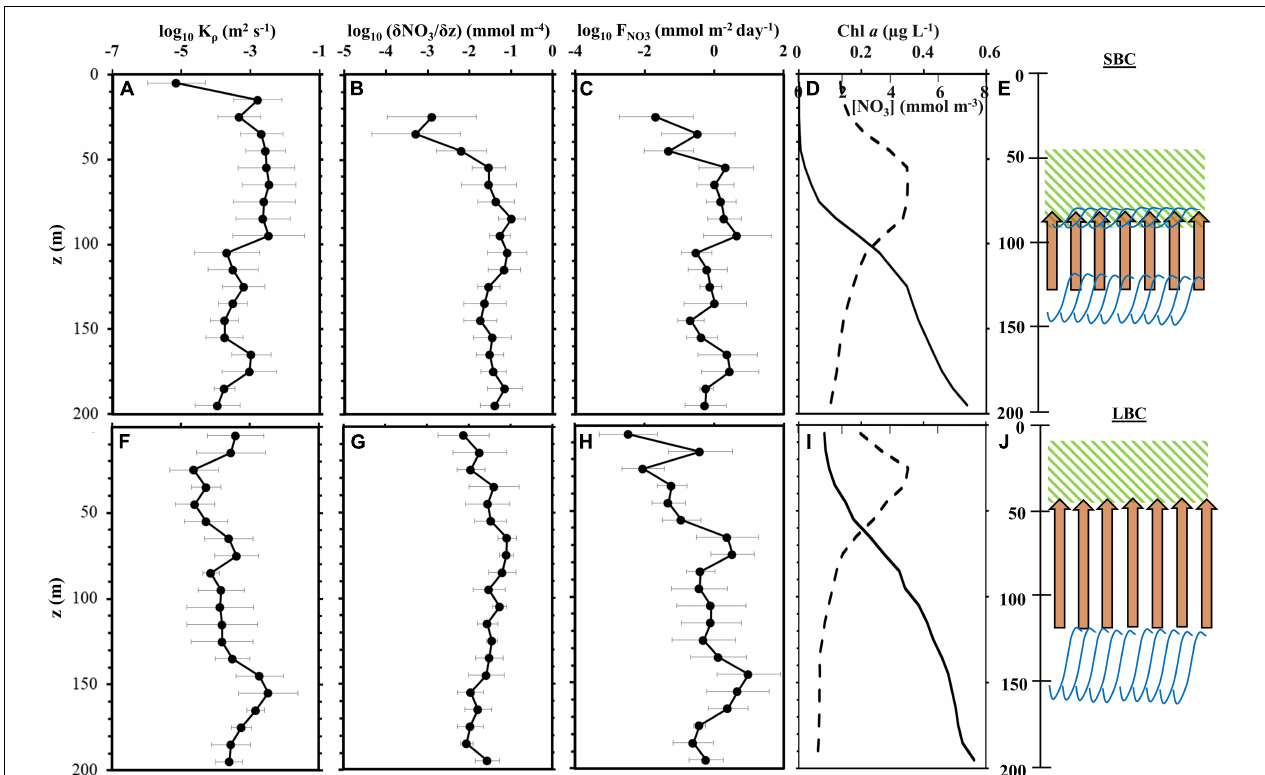
FIGURE 7 | The top (SBC) and bottom (LBC) rows include vertical profiles of environmental parameters on the K seamount. Profiles of eddy diffusivity, K ρ (A,F) , nitrate gradient (B,G) , and vertical nitrate flux, F NO 3 (C,H) from all casts deployed on K2 station are shown. Gray solid lines are relative standard deviations. The vertical profiles of averaged Chl a (dashed line; upper top axis label) and nitrate (solid line; lower top axis label) concentrations are shown (D,I) . Schematic of the approximate locations of nutrient uplift (the starting point of the orange arrows indicate the depth where abrupt changes in the nitrate isolines were observed based on Figures 3C,D ; the arrowheads mark the 1.5 mmol m − 3 nitrate isoline), KH billows (blue curved lines), and subsurface chlorophyll maximum (SCM; green hatched box) within the water column during the SBC ( E ; two billow layers) and LBC (J) . Based on the time-series sampling at station K2 where KH billows were observed ( Figure 3 and Supplementary Figures 3 , 4